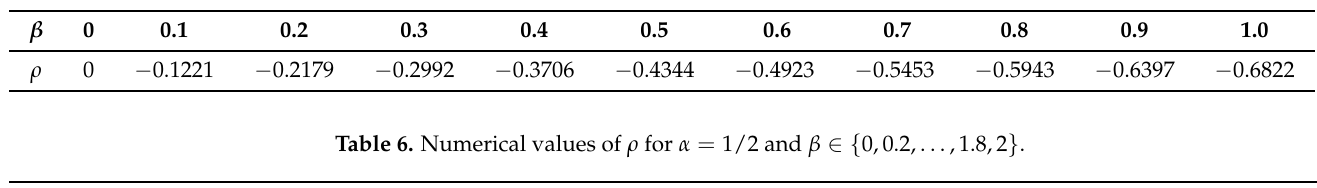
Table 5. Numerical values of ρ for α = 1 and β ∈ { 0,0.1, . . . ,0.9,1 } .